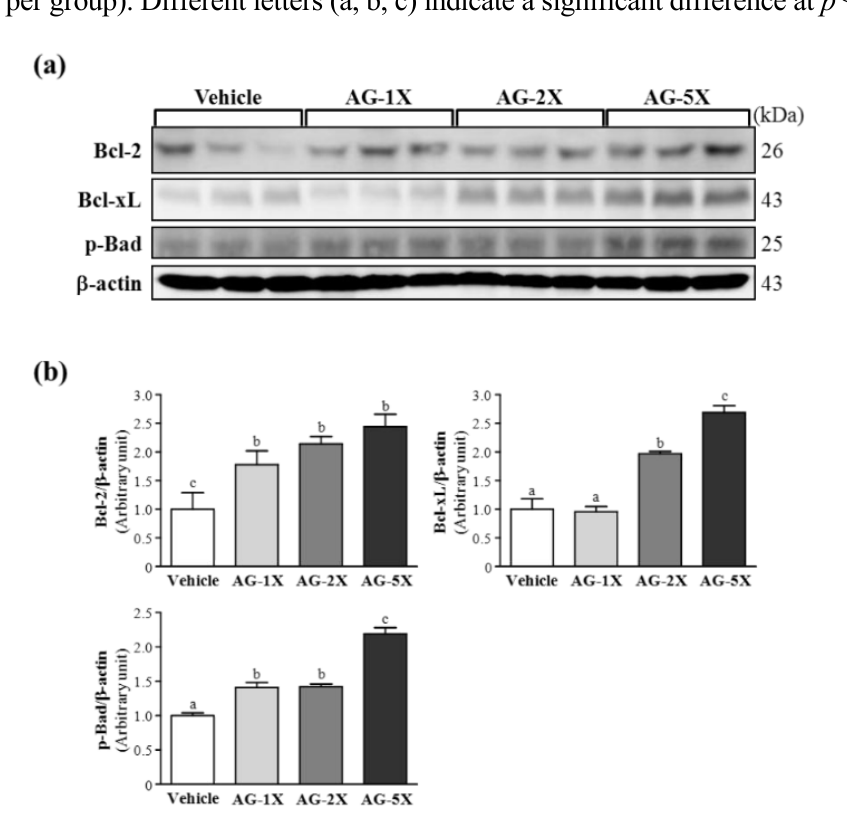
Figure 6. Effect of AG supplementation on anti-apoptosis protein expression in rat stomachs. Rats were treated as in Figure 4. ( a ) Western blot analysis and quantification of protein levels of Bcl-2, Bcl-xL and p-Bad in gastric tissue; and ( b ) Densitometry analysis was performed to quantify the expression levels of detected proteins. Data are mean ±